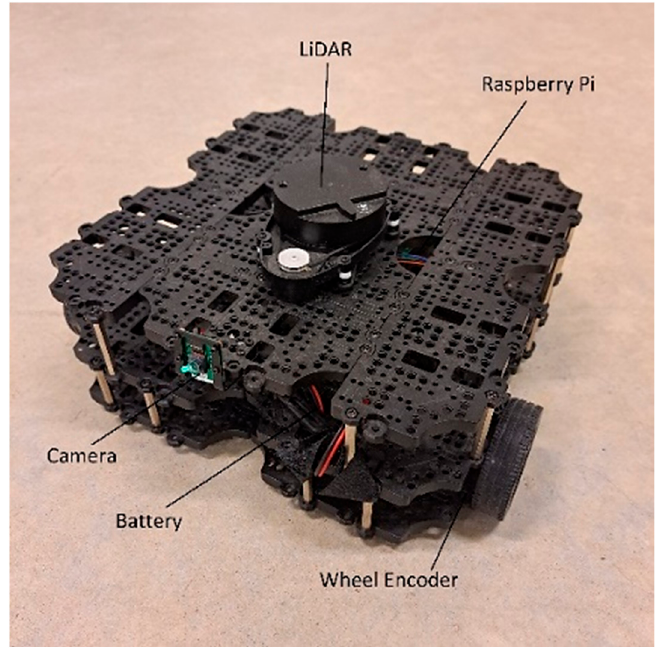
Figure 3. Indoor mobile robot-Turtlebot 3 Waffle Pi. Table 2. Turtlebot 3 and LiDAR Specifications [20]. Turtlebot 3–Waffle Pi: Specifications